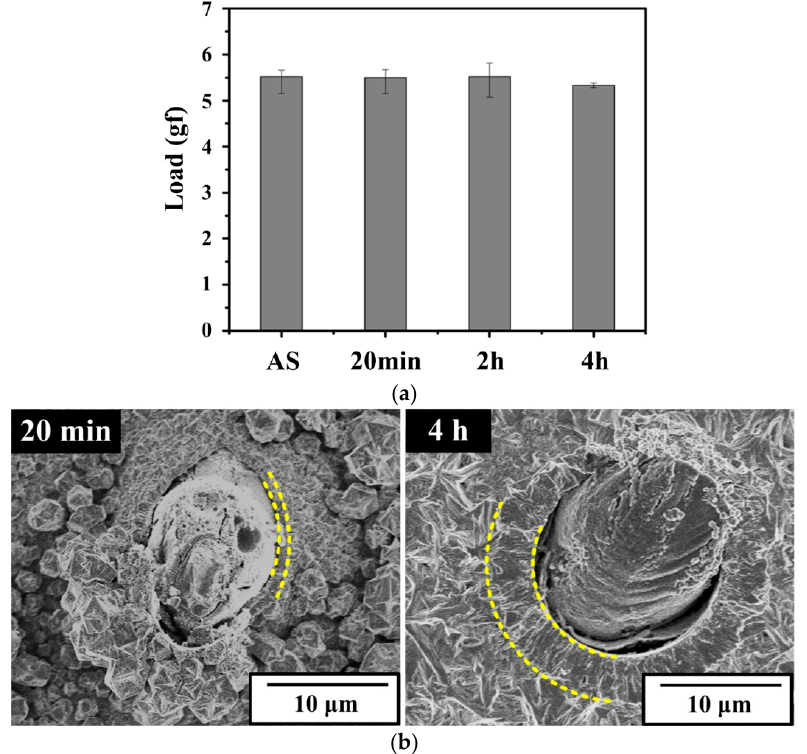
Figure 5. ( a ) Fracture load and ( b ) fracture surface of PCA ball bond wire after sulfidation.